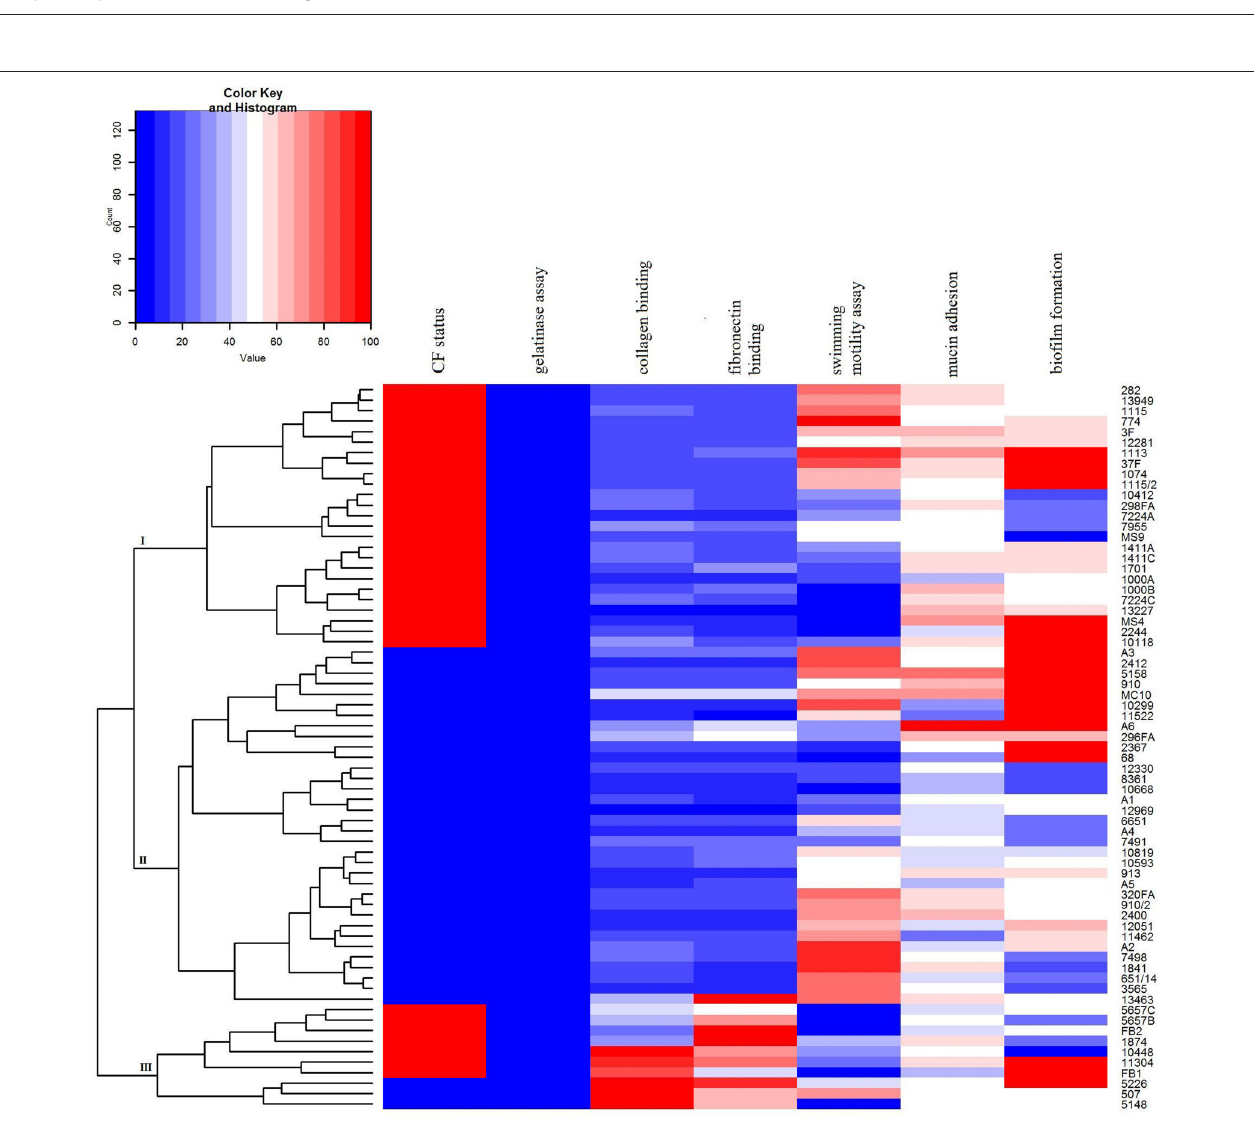
Frontiers in Cellular and Infection Microbiology |